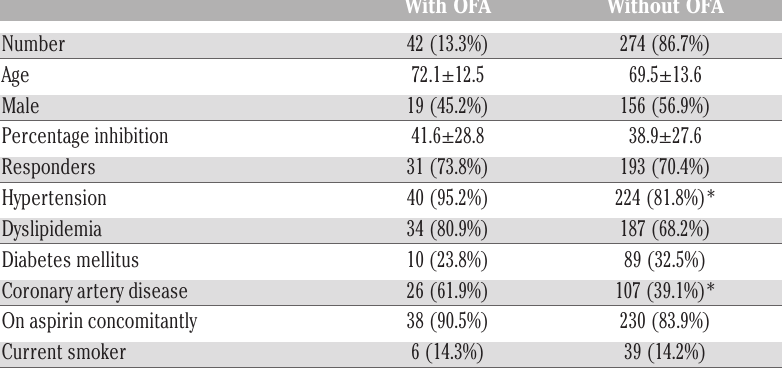
Table 2. The characteristics of subjects who were taking clopidogrel at